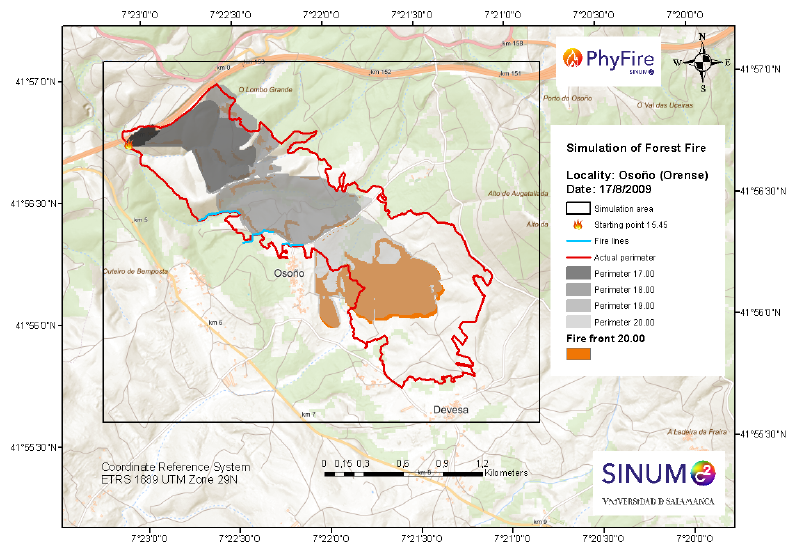
Figure 3. Simulation area (black rectangle), fire ignition point, actual final perimeter (red line), fire- fighters’ firebreaks (blue lines), simulated burned areas each hour, and fire front at 20.00, considering the effect of fuelbreaks by modifying the initial fuel